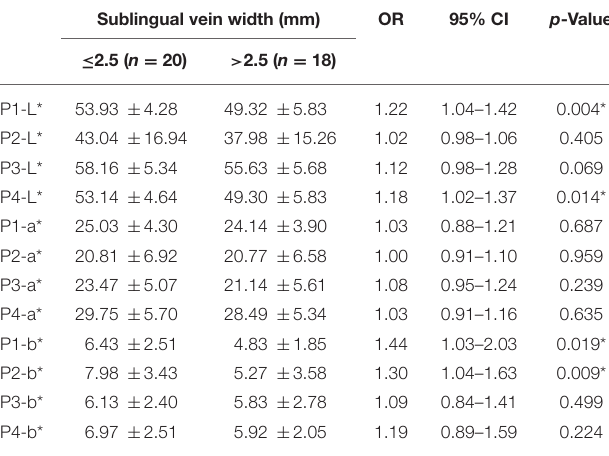
TABLE 3 | Association between the tongue color values and sublingual vein width. Sublingual vein width